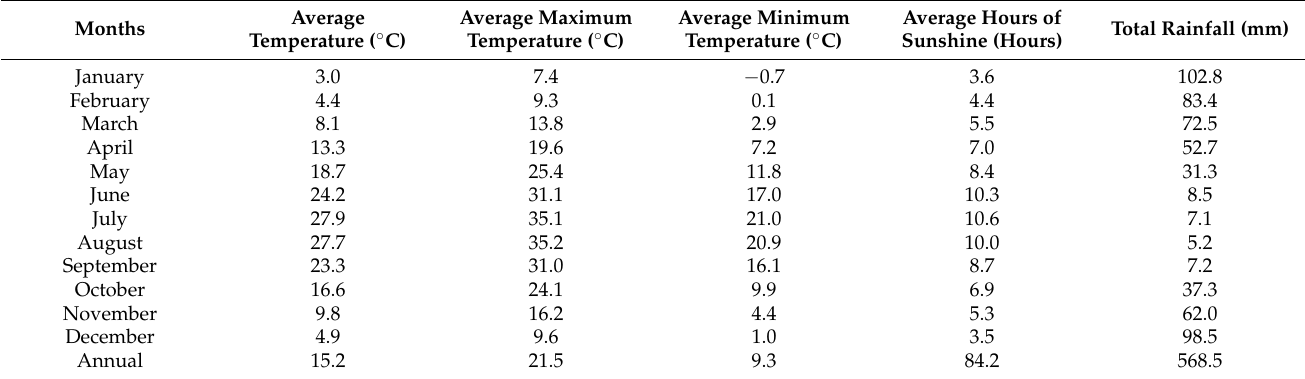
Table 1. Average climatic values obtained for the 2018–2019 growing period in Gaziantep region in Turkey [36]. Average Months Temperature ( ◦